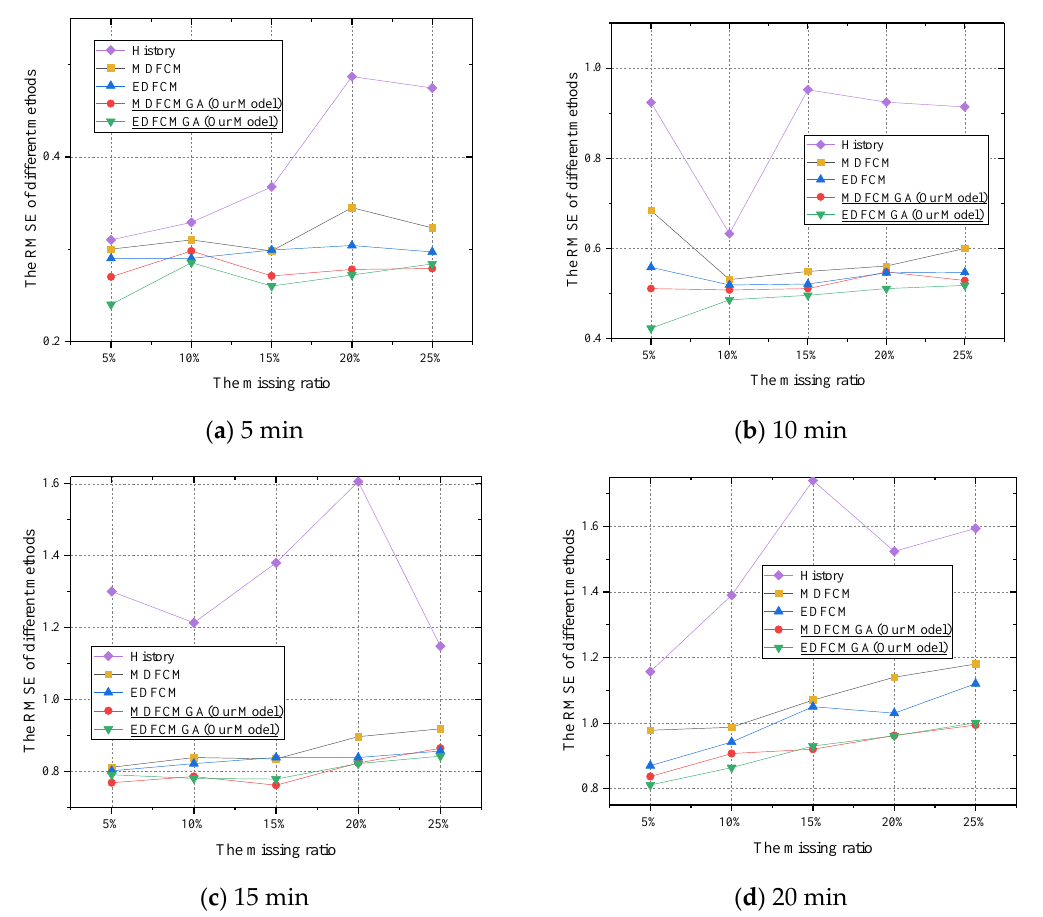
Figure 6. Root mean squared error ( RMSE) comparisons under the condition of different data aggregation intervals and different missing ratios.